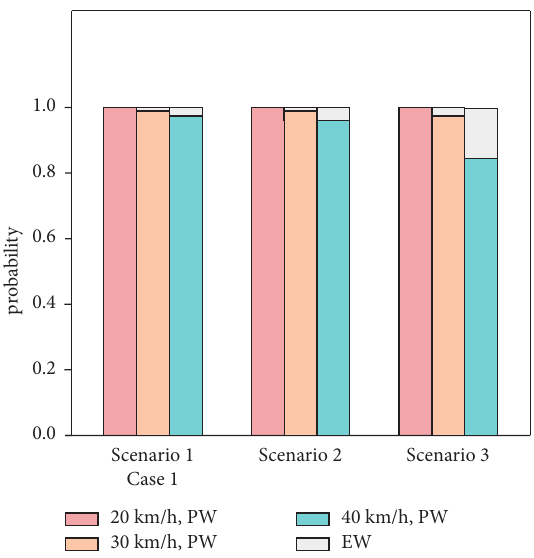
Figure 21: Test results for scenarios 2 and